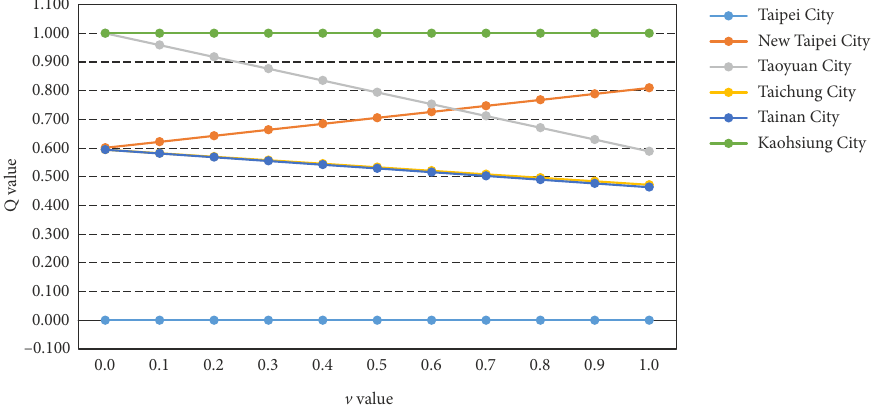
Figure 9. Simulation of the six cities for different v value in technological capability aspects